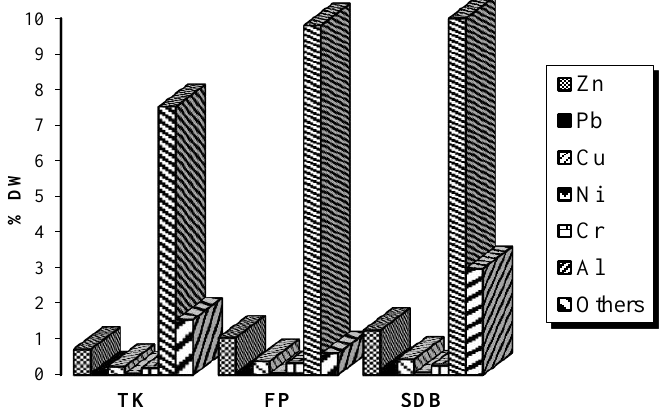
Figure 3. Average heavy metal contents of sludge in dry weight samples taken from Thickener (TK), Filter Press (FP), and Sludge Drying Bed (SDB) of AWWTP